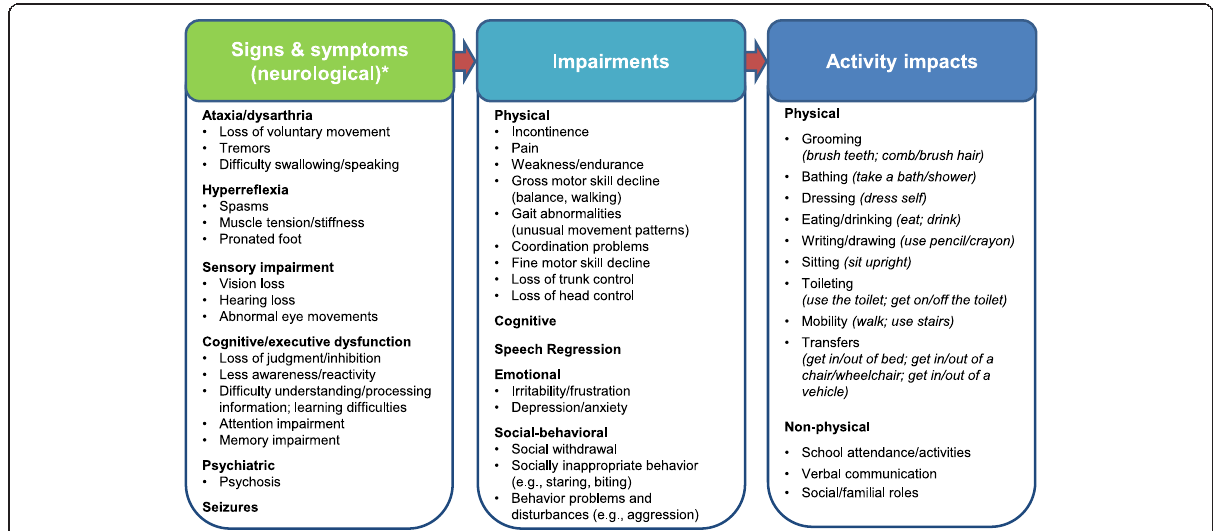
Fig. 2 Juvenile metachromatic leukodystrophy conceptual disease model. Content in italics denote the 15 concepts represented in the IMPA scale. While this model depicts both physical and nonphysical functioning effects and ADL impacts, the goal of the IMPA scale was to measure observable impairments in physical functioning. *This model was based on an early model developed in the previous research and modified based on the research conducted in the current study. IMPA = Impact of Juvenile Metachromatic Leukodystrophy on Physical